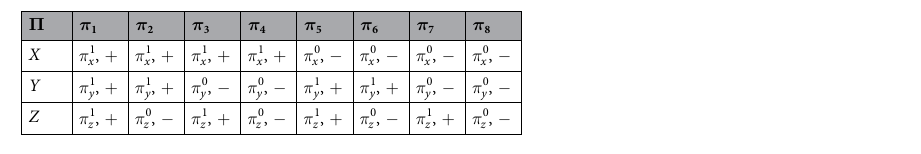
Table 2. Order patterns in three dimensional time series ( x ( t ), y ( t ), z ( t